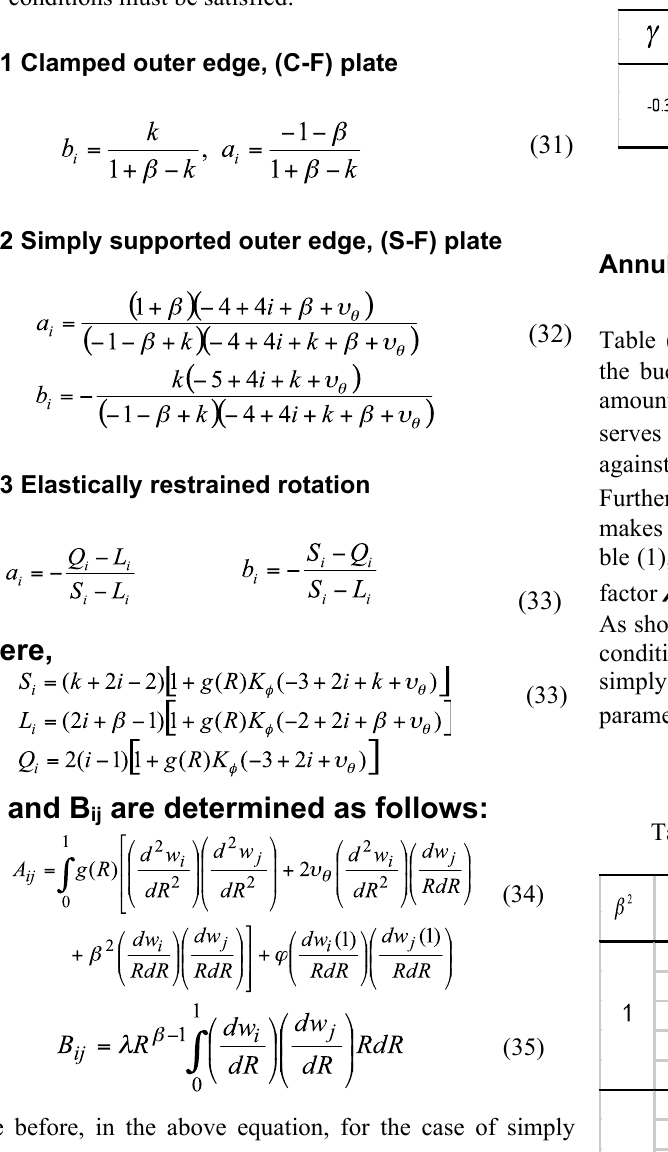
Table (1): Convergence study for annular orthotropic plate